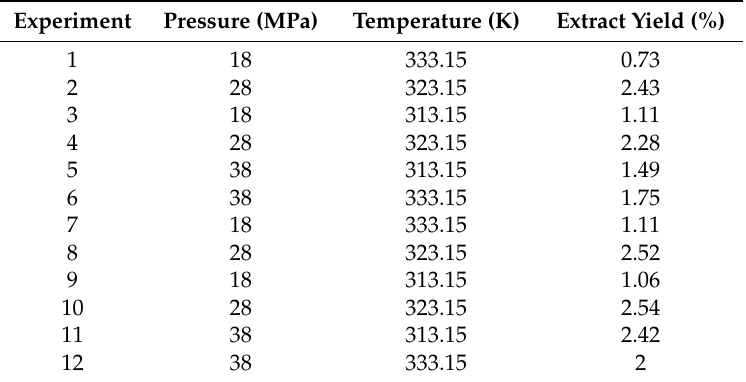
Table 1. Extract yield of P. tuberosa flowers and experimental design.